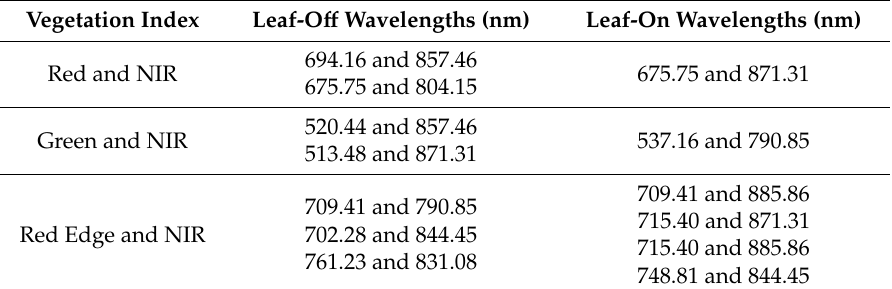
Table 7. Evaluation of the total and spruce tree densities among all sample plots ( n = 15) (TPH = Trees per hectare).